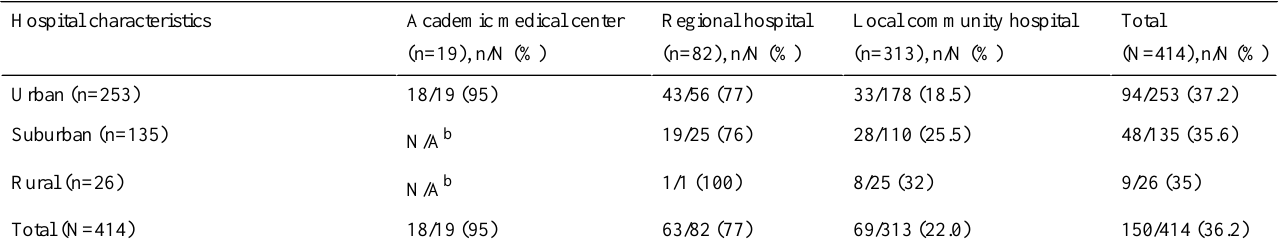
Table 1. Proportion of apps (n=150) developed in all hospitals (N=414), stratified by accreditation type and urbanization level a .